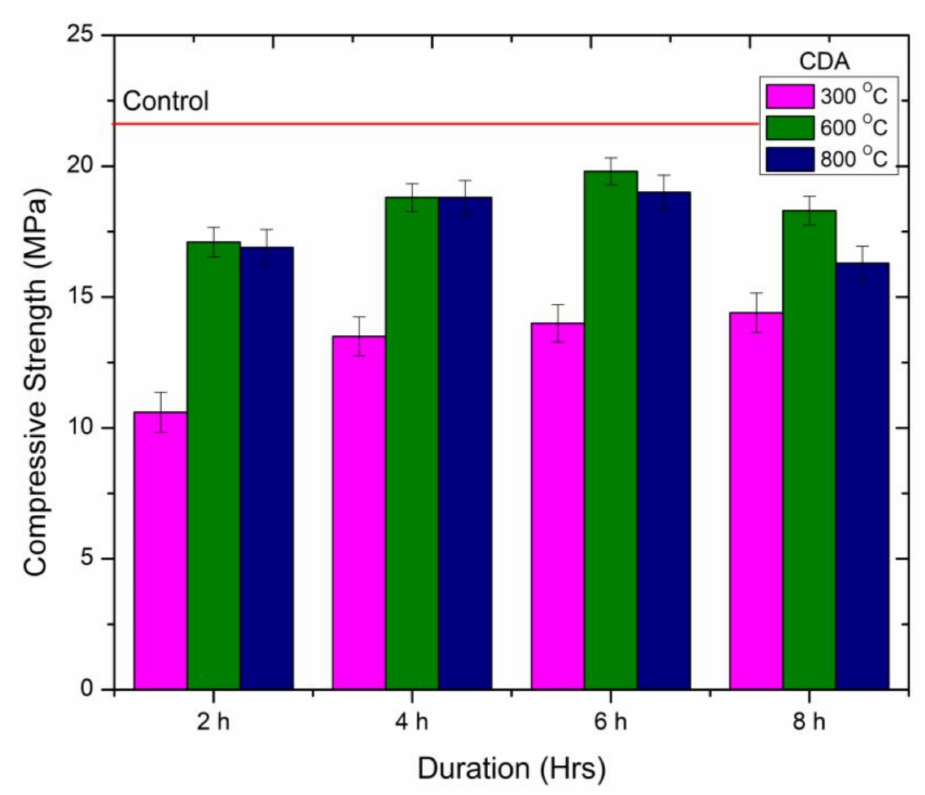
Figure 6. Compressive Strength behavior of CDA-cement mortar at different calcination